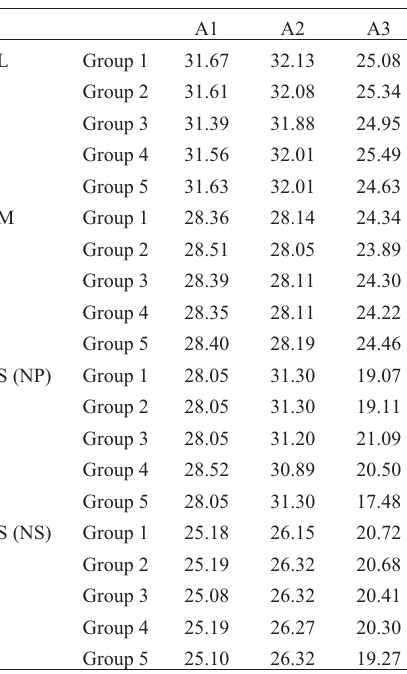
Table 2 - Nucleotide composition of RVFV